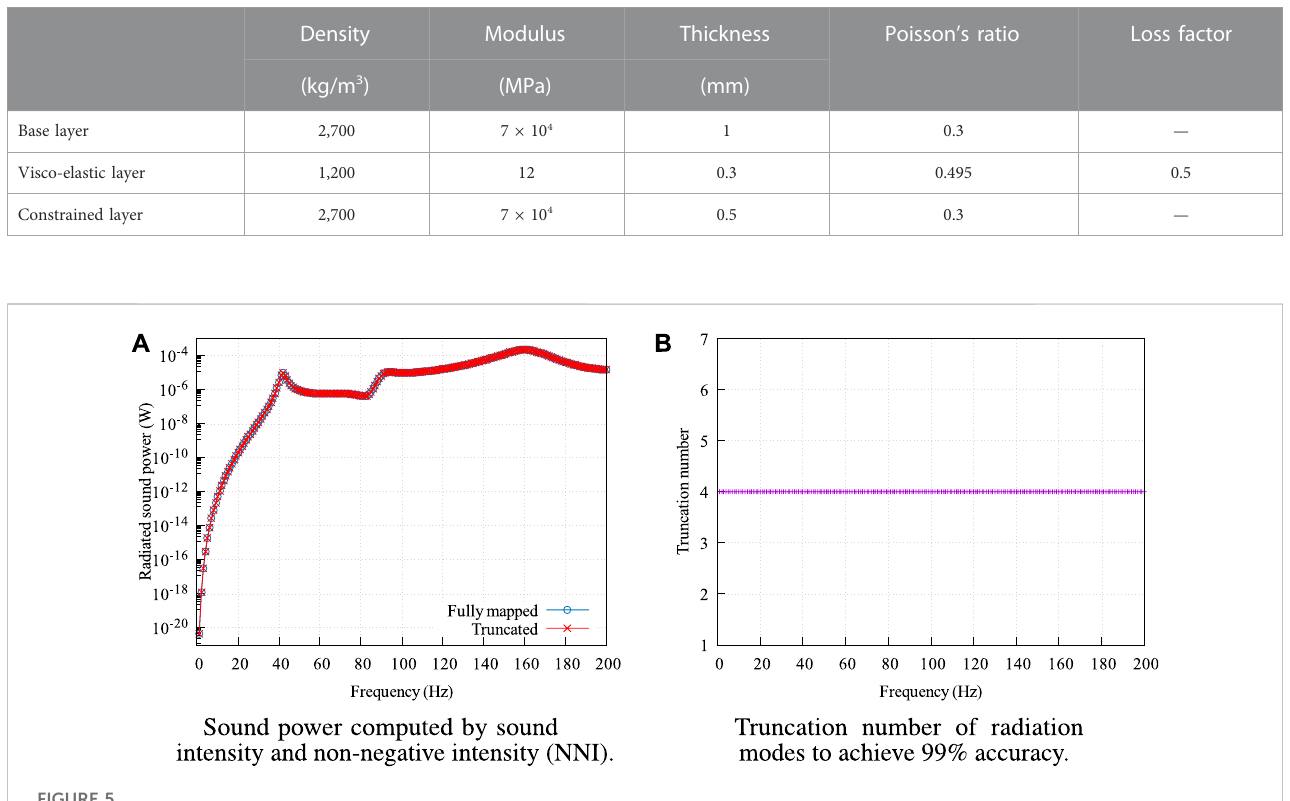
TABLE 1 Material properties of the constrained-layer damping